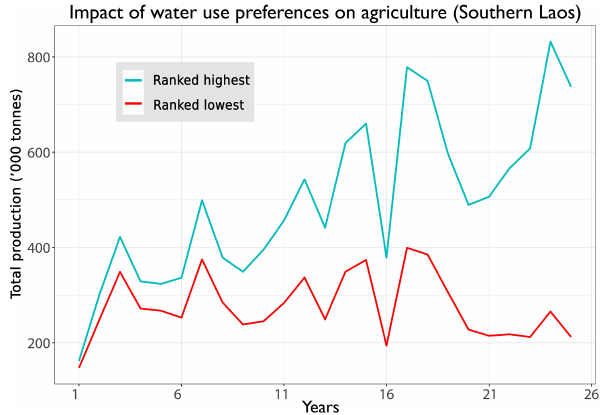
Figure 4. Difference in crop production caused by the differing pri- oritization of agriculture for the southern Laos